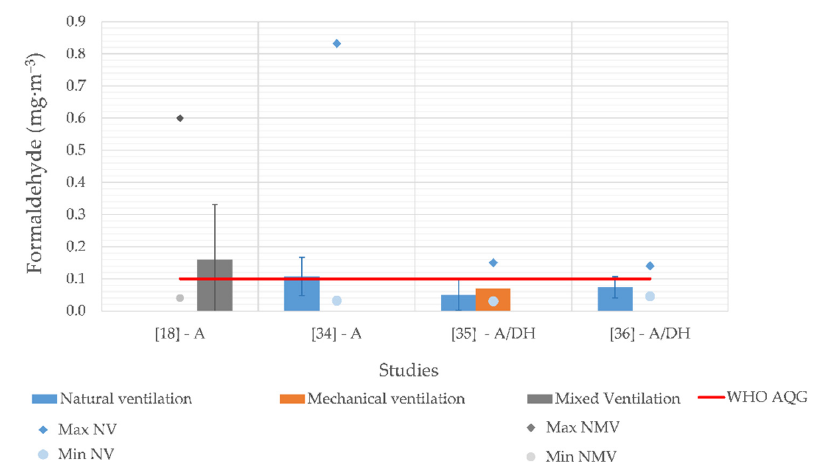
Figure 7. Formaldehyde levels monitored during the sleep period at bedrooms in different types of building (A—apartment; A/—mixed (apartment and detached house); DH—detached house) and different types of ventilation settings (NV—natural; mechanical—MV; mixed—NMV). Bars provide mean values (along with standard deviation when available). WHO AQG stands for the air quality guideline value recommended by WHO [41], and max and min stand for maximum and minimum values, respectively.